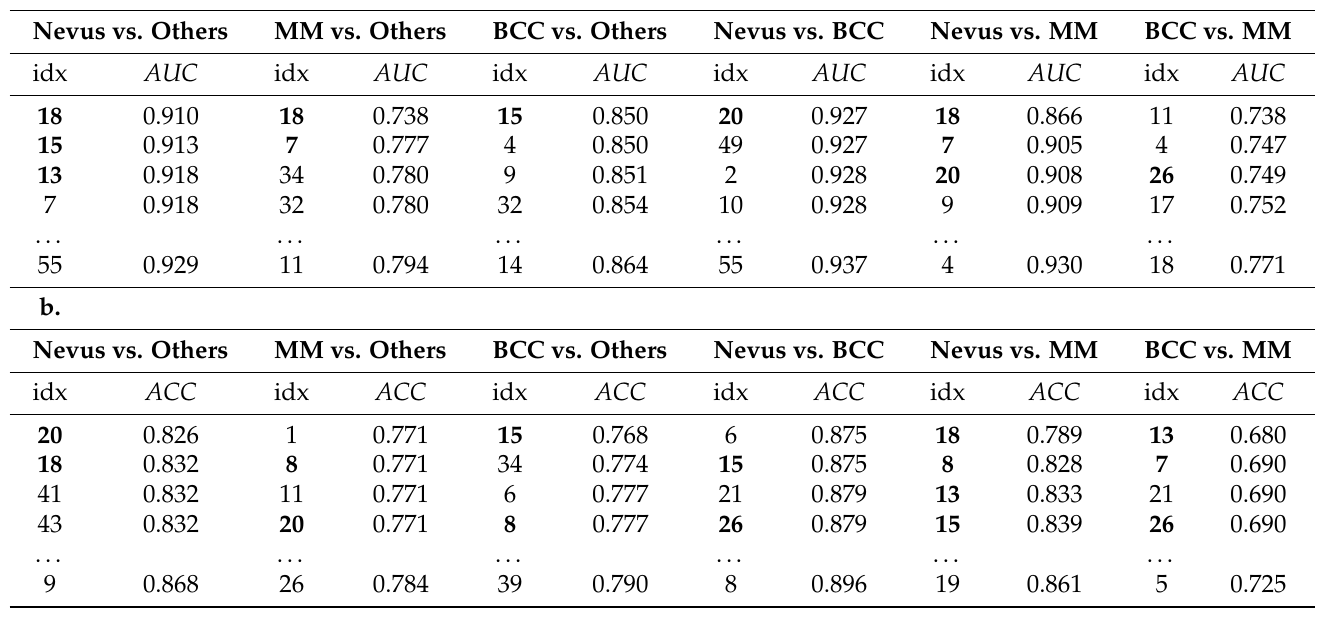
Table 5. Features performance. AUC ( a ) and ACC ( b ) measures of binary classifications using LAR-based segmentation are presented for the cases of leaving one feature out from the feature set of the classification framework. The results ( AUC and ACC ) are presented in ascending order, showing the omitted features in descending order regarding their contribution to the performance of the full framework. The features are represented by their index in the feature set of the framework. The top four rows for each of the six binary classification tasks are presented, together with the last row as a reference. The full list of the features (with feature names and corresponding indices) can be found in Section 2.3, Feature extraction. Features appearing at least three times in the top four are highlighted in bold .